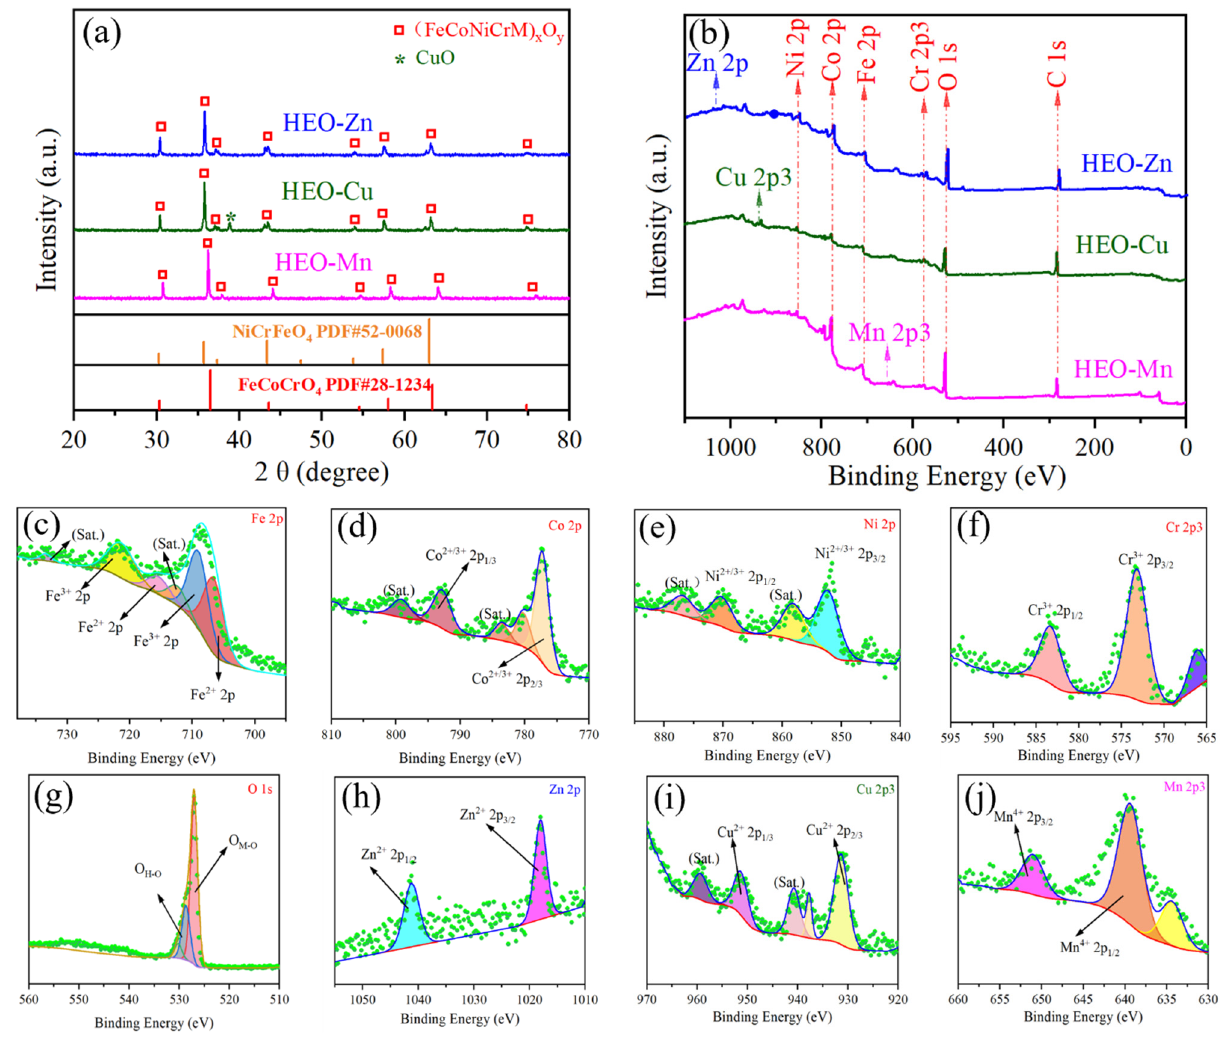
Figure 3. ( a ) XRD pa tt erns, ( b ) XPS spectrums of HEO − Zn, HEO − Cu, and HEO − Mn samples. ( c – g ) are the XPS spectra of Fe 2p, Co 2p, Ni 2p, Cr 2p, and O 1s of HEO − Cu, and ( h – j ) are the XPS spectra of Zn 2p of HEO − Zn, Cu 2p of HEO − Cu, and Mn 2p of HEO − Mn, respectively.